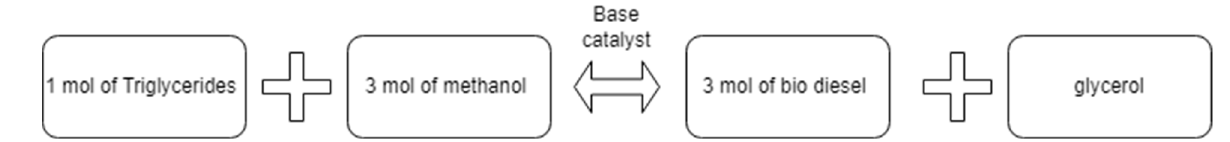
Figure 5. Transesterification reaction of biodiesel from triglycerides.